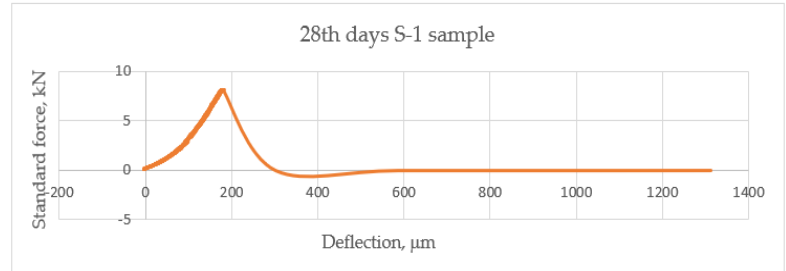
Figure 8. 28th day S-1 sample’s crack behavior.